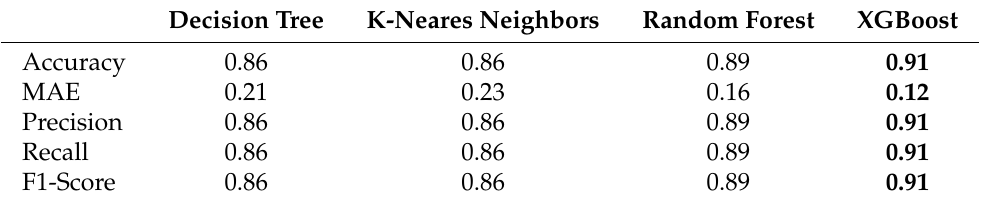
Table 1. Comparison of classifiers algorithms with quartiles segmentation. This table shows that the XGBoost algorithm is the optimal one of the four to be compared since it presents the best accuracy, with the lowest mean absolute error.